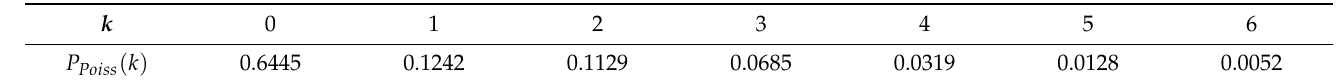
Table 6. The probabilities of k success of the Poisson distribution— P Poiss ( k ) .